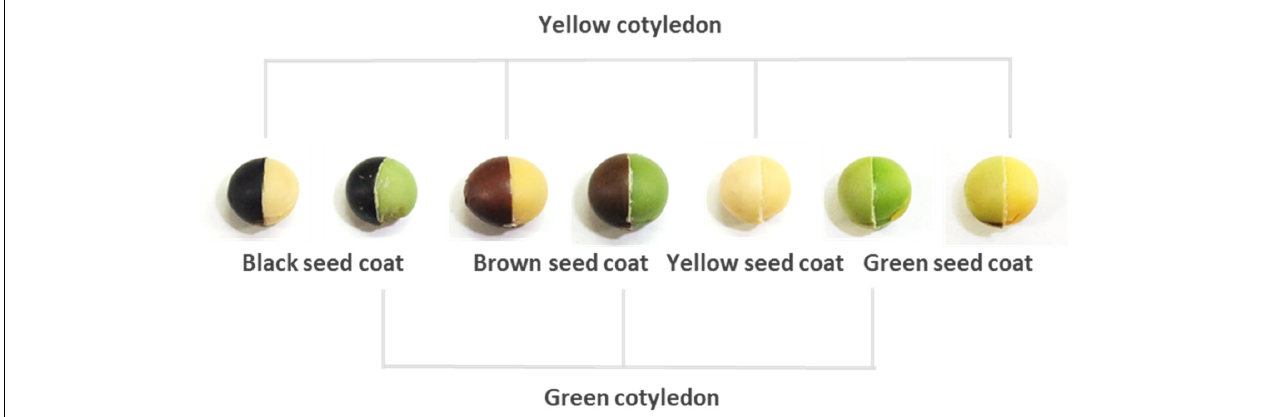
FIGURE 1 | Representative seed coats and cotyledon colors in soybeans. The right half of each seed has the seed coat removed to expose the